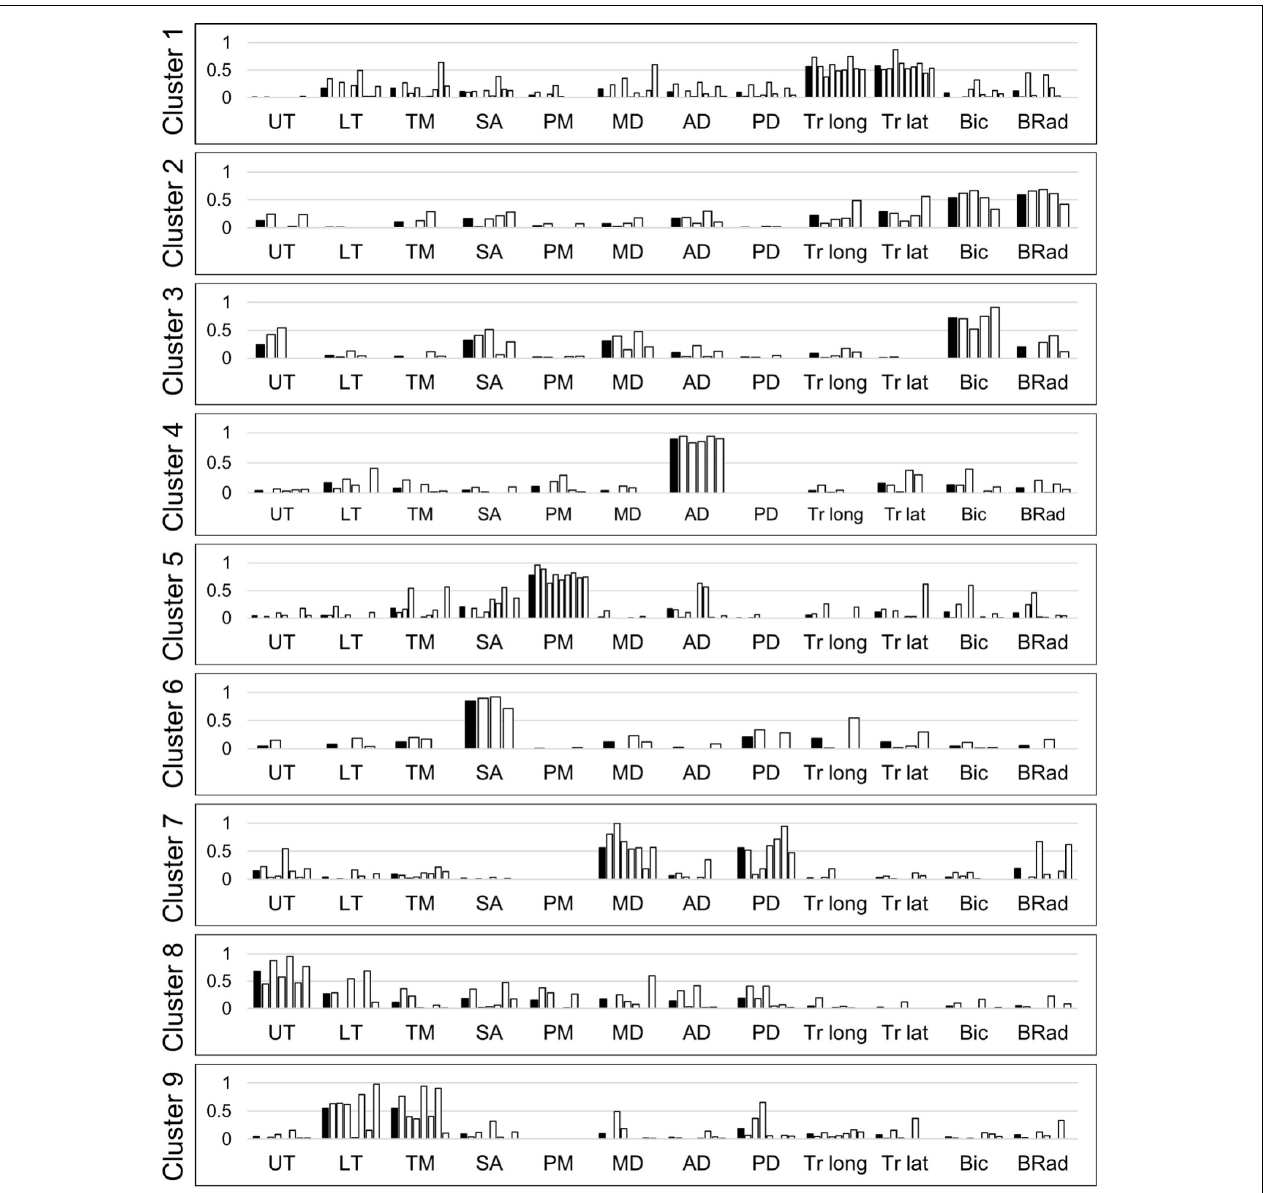
FIGURE 6 | Nine clusters of upper limb muscle synergies. White bars represent muscle synergies identified from the data of individual subjects. Black bars represent the average of the muscle synergies (i.e., cluster centers). UT, upper trapezius; LT, lower trapezius; TM, teres major; SA, serratus anterior; PM, pectoralis major; MD, middle deltoid; AD, anterior deltoid; PD, posterior deltoid; Tr long, triceps long head; Tr lat, triceps lateral head; Bic, biceps; BRad, brachioradialis.